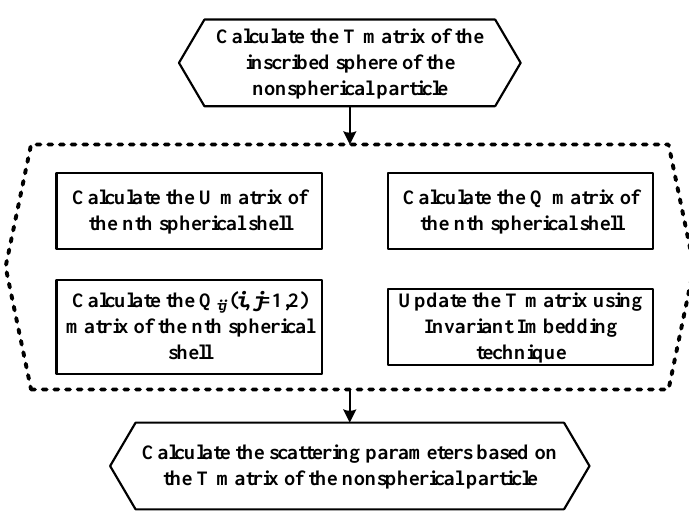
Figure 3. A schematic diagram of the implementation of our invariant imbedded (IIM) T-Matrix code.